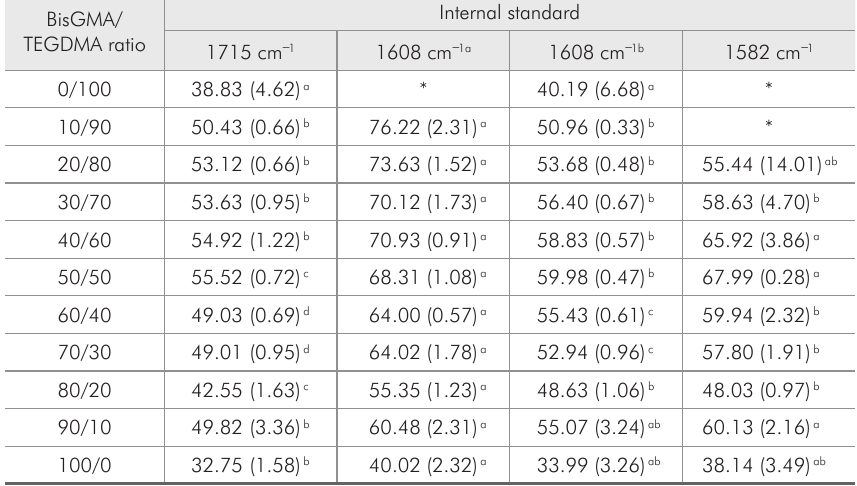
Table 2 - Mean (standard deviation) DC (%) for BisGMA/ TEGDMA blends, measured using different internal standard peaks.